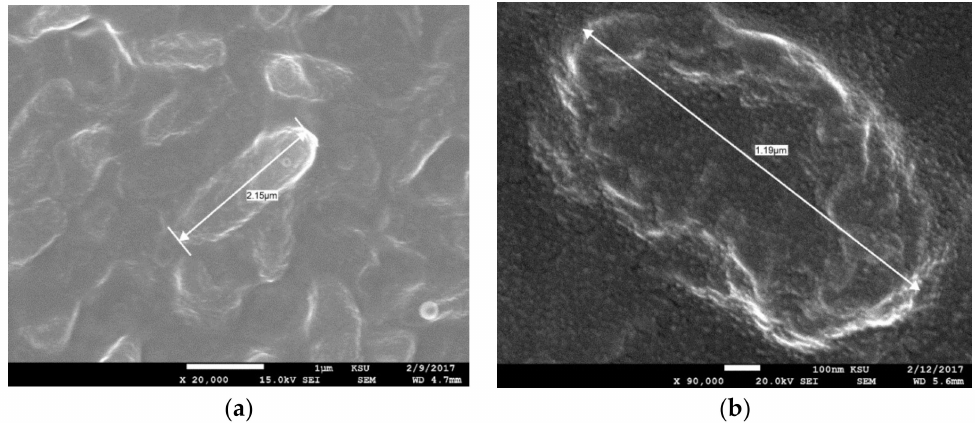
Figure 3. SEM micrograph of Pseudomonas aeruginosa loaded with AgNPs ( a ) normal cell ( b ) treated cell with AgNPs with abnormal cell wall which is also short compared to the untreated cells.